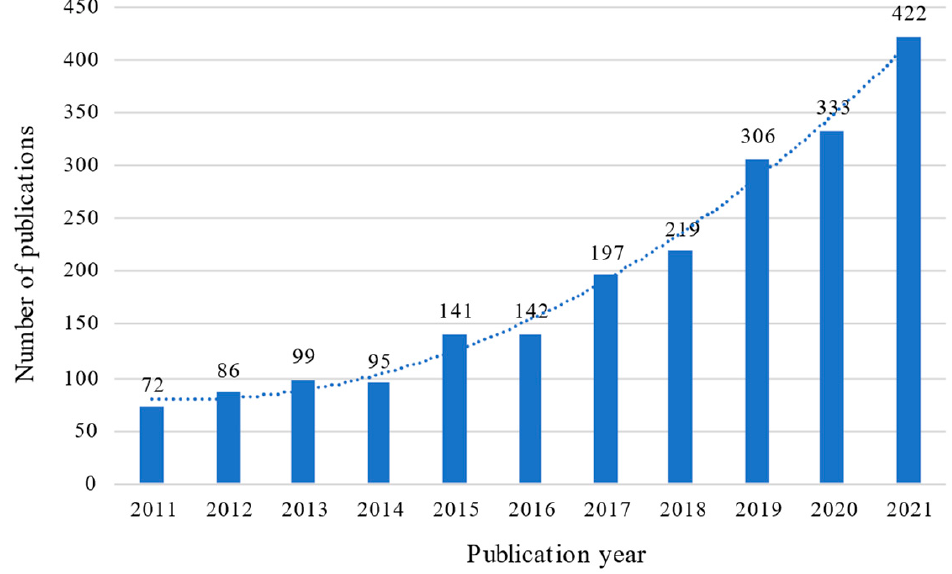
Figure 1. Bibliometric analysis of publications about textile recycling between 2011 and 2021. The data were retrieved from the Web of Science database in August 2022, using the criteria that all fields were searched with the keyword combination “textile*”and “recycl*”.